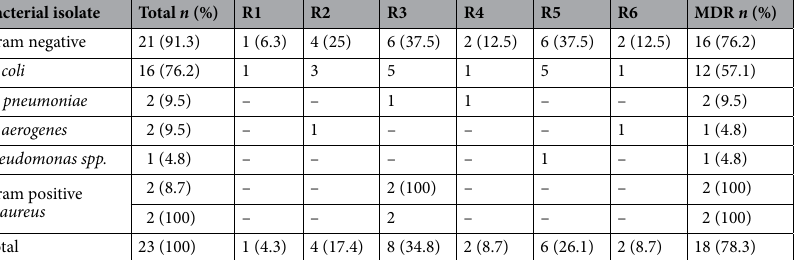
Table 5. Multi-drug resistance pattern of bacterial isolates from urine culture of adult people living with HIV attending Hawassa University Comprehensive Specialized Hospital ART clinic, Hawassa, Ethiopia, from September 17–November 16, 2018 (N = 23). R resistance, n number, MDR resistance for three group of drug. R1—resistance to one group of drug; R2—resistance to two group of drug; R3—resistance to three group of drug; R4—resistance to four group of drug; R5—resistance to five group of drug; R6—resistance to six group of drug.